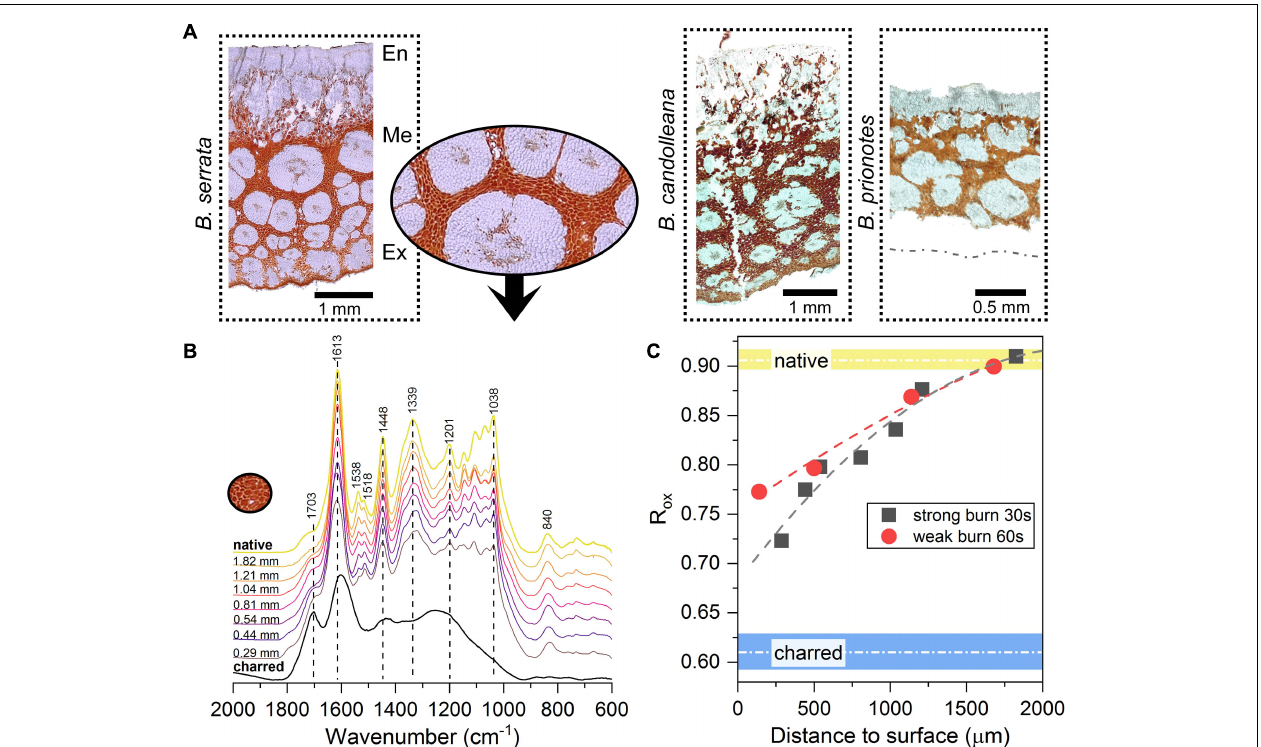
FIGURE 7 | Characterisation of the anti-oxidative tannin network in the valve tissue. (A) Light micrographs of unstained follicle cross-sections from all three Banksia species, showing networks of tannins-rich parenchymatic tissue (in red/orange, inset for B. serrata ) surrounding thick-walled fibre bundles (white) in the mesocarp (Me). En: endocarp; Ex: exocarp. (B) FT-IR spectra of B. serrata tannins from different depths below the surface of a burnt follicle (30 s of flame exposure, distance to the follicle surface indicated) compared to ‘native’ and charred. (C) Ratio of aromatic to carboxylic absorption bands [1613 cm - 1 /(1703 cm - 1 ++ 1613 cm - 1 )] for samples with two different flame exposures allows to quantify the state of the condensed tannins. Short burnings of 30 and 60 s mainly affect the tissue in the outermost valve layer and causes oxidation of the condensed tannins to a depth of only 1.5–2 mm below the surface. Data fitted with a 2nd order polynomial function, native and charred are averages obtained from 4 spectra ±